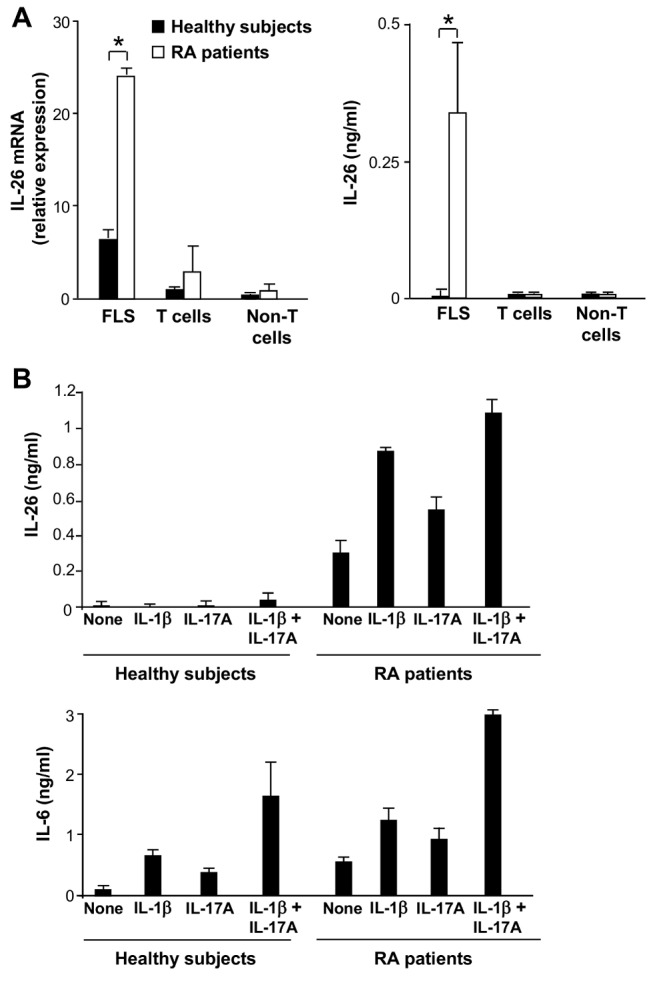
Synovial fibroblasts are the main IL-26-producing cells in RA joints.(A) FLS from RA patients and healthy subjects (n = 3), and T cells and non-T mononuclear cells (isolated from RA SF cells and from PBMC of healthy subjects) (n = 3), were either unstimulated or stimulated with anti-CD3 plus -CD28 mAbs or soluble CD40L, respectively. IL-26 mRNA expression (expressed as relative mRNA expression) was analyzed by RT-qPCR after 6 h stimulation (left panel) and IL-26 production (in ng/ml) was determined by ELISA after 48 h stimulation (right panel). Results are expressed as mean ± SD, n = 3; *p<0.05 (Wilcoxon matched-pairs signed-ranks test). (B) IL-26 (upper panel) and IL-6 (lower panel) were quantified by ELISA in the supernatants of FLS from healthy subjects and RA patients, stimulated or not with 50 ng/ml IL-1-beta and/or IL-17A. Results are expressed in ng/ml (mean ± SD, n = 3).